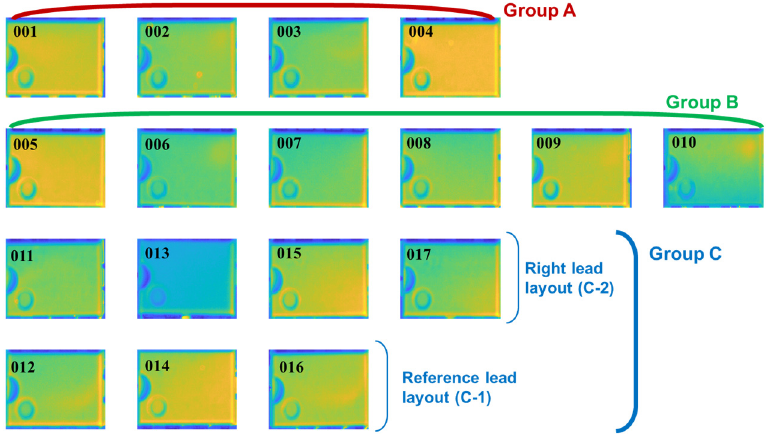
Figure 11. The first temperature frame (0.04s) after the flash.